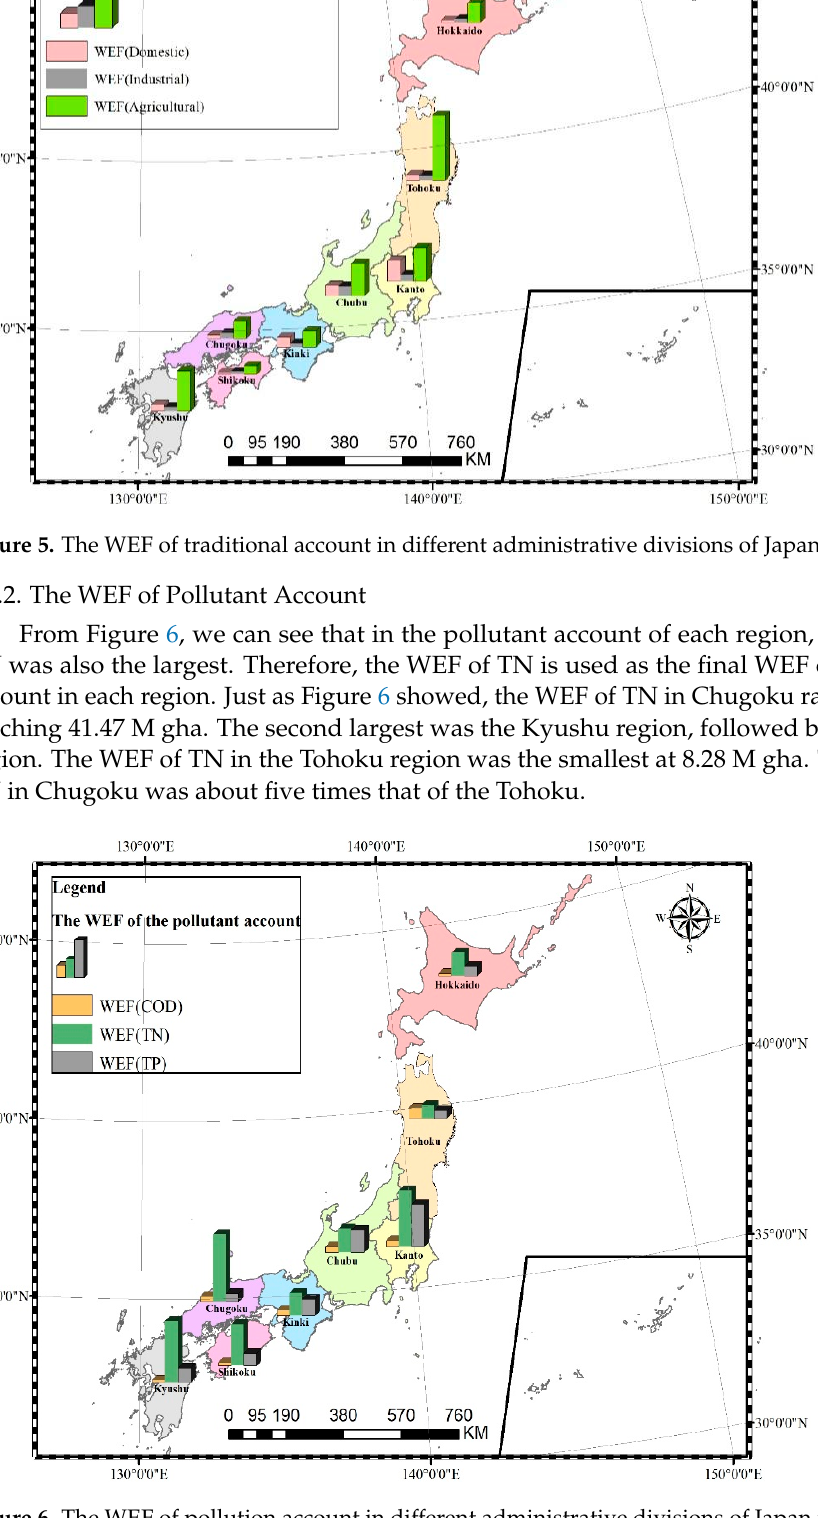
Figure 6. The WEF of pollution account in different administrative divisions of Japan in 2020 (Unit: 1 M gha). 1 M